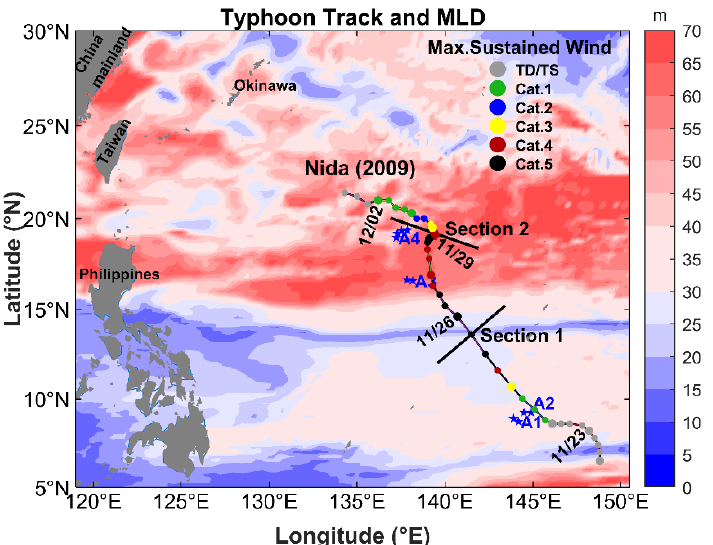
Figure 1. Best track of typhoon Nida (2009) from the JTWC. The blue stars denote the positions and trajectory of Argo floats (A1 to A4 are floats 5902121, 5901213, 5900976, and 2900401). The track line color indicates the MSW speed of the typhoon. The background pattern is the MLD field on 22 November before the passage of typhoon. The two black sections indicate the location of the strongest intensity (section 1) and maximum turning (section 2).